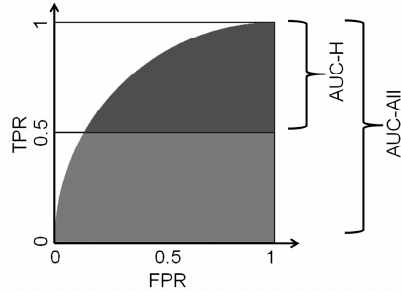
Figure 4. Illustration of over-all performance measure (denoted as AUC-All), and of high-TPR performance measure (denoted as AUC-H). TPR stands for true positive rate, and FPR stands for false positive